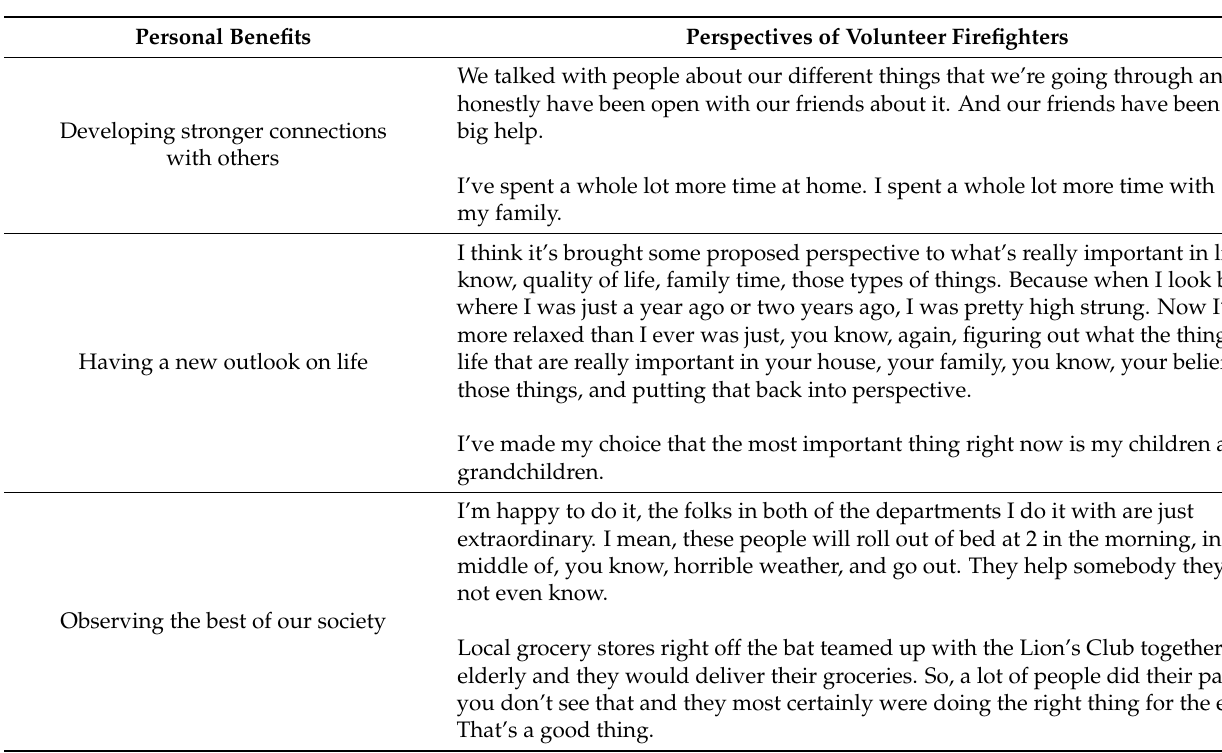
Table 5. Personal Silver Linings of the COVID-19